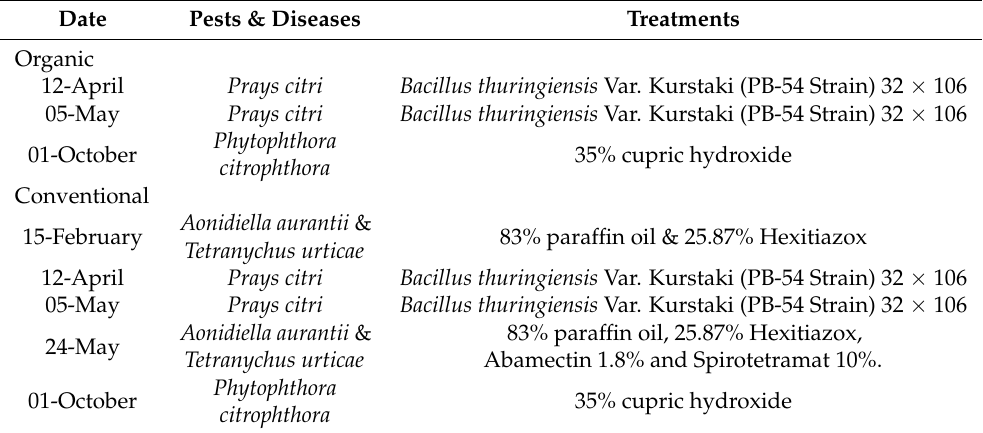
Table 1. Treatments to control pests and diseases at experimental